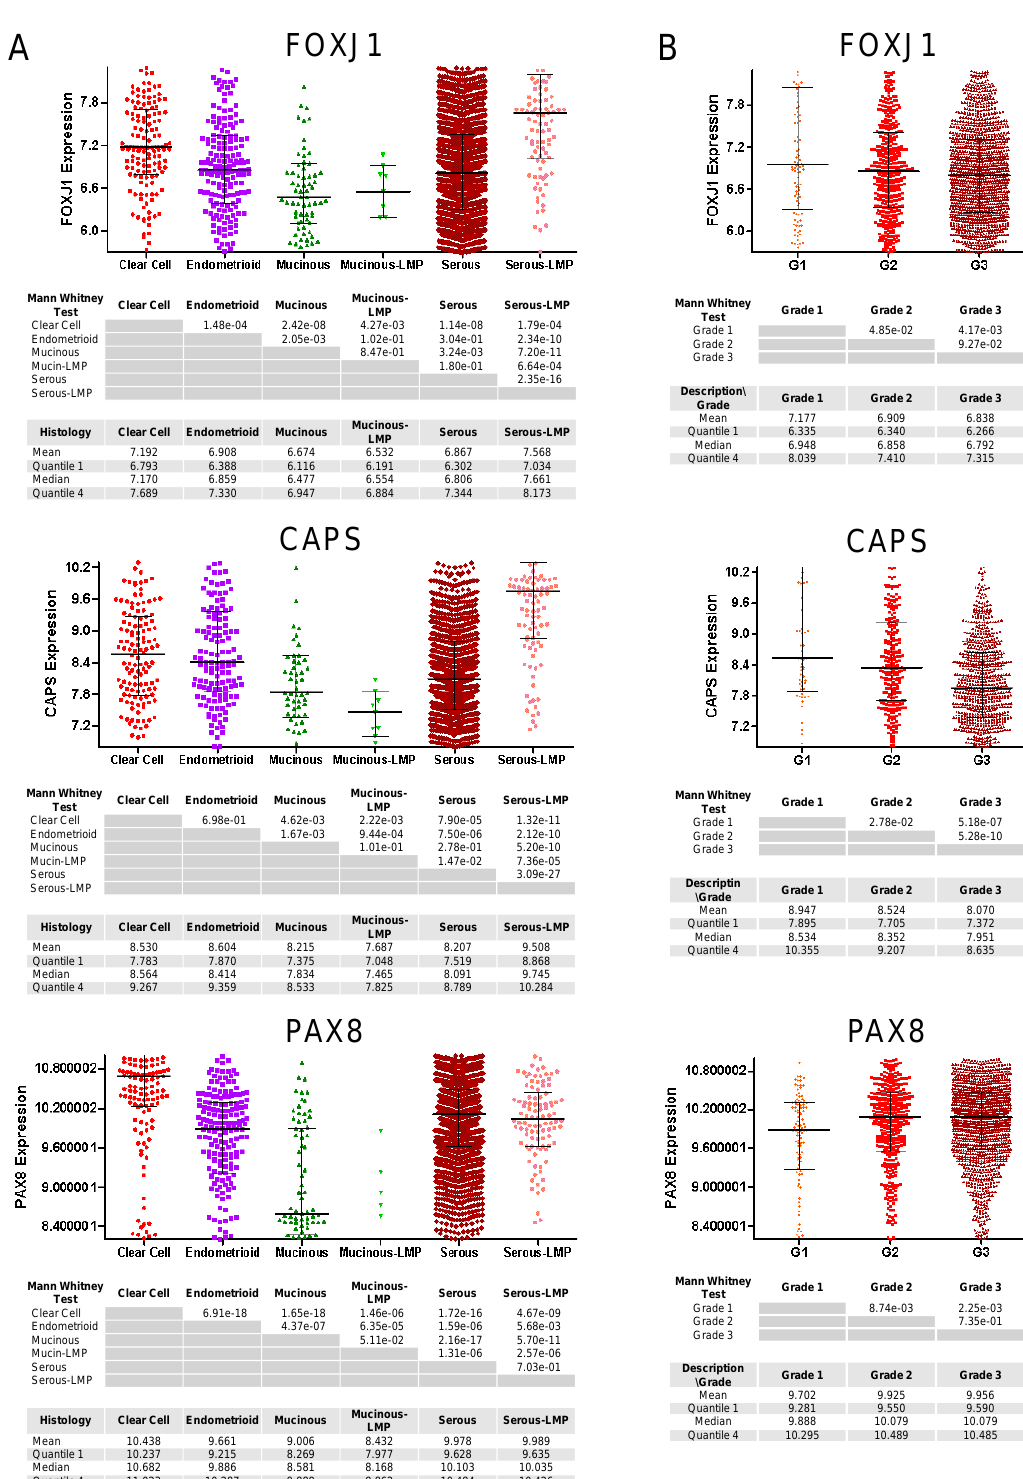
Figure 4. mRNA expression of ciliated cell markers FOXJ1 and CAPS and a secretory cell marker PAX8 in ovarian carcinomas (clear cell, endometrioid, mucinous, and serous) and borderline (LMP) tumors (mucinous, serous). ( A ) histologic subtypes and ( B ) cancer grade for all histologic subtypes combined. Y-axes represent relative mRNA